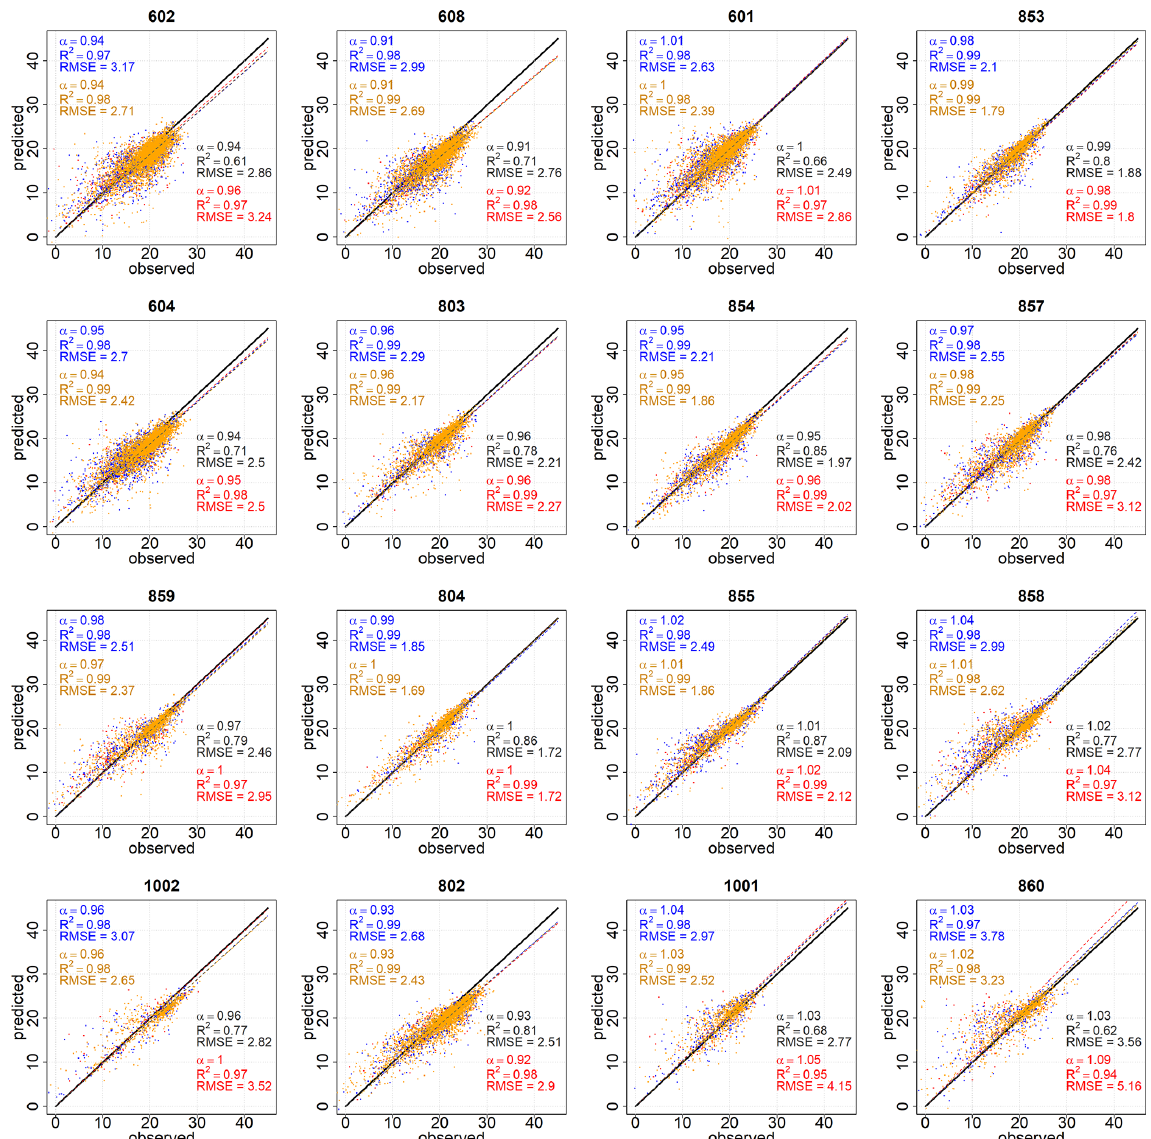
Figure B1. Linear fits of daily deseasonalized predicted vs. observed R g (MJm − 2 d − 1 ) at each one of the selected stations for the global data (black) and cloudy (CI < 0.3 – red), partly cloudy (0.3 < CI < 0.6 – blue), and clear-sky (CI > 0.6 – orange) days. Stations are sorted by increasing altitude from left to right and from the top to the bottom